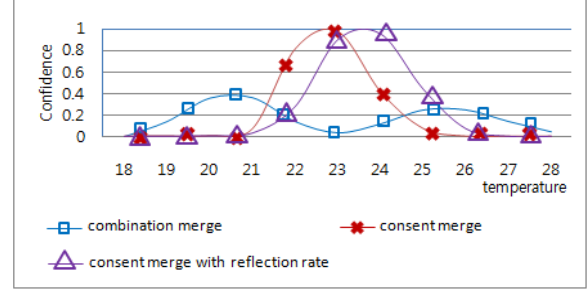
Fig. 2. The range of the confidences in merged context